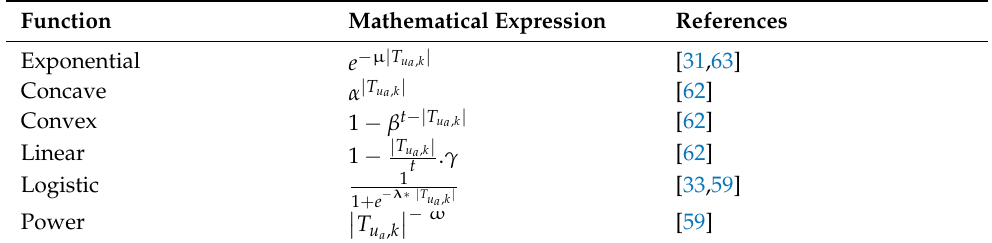
Table 8. List of Time Decay